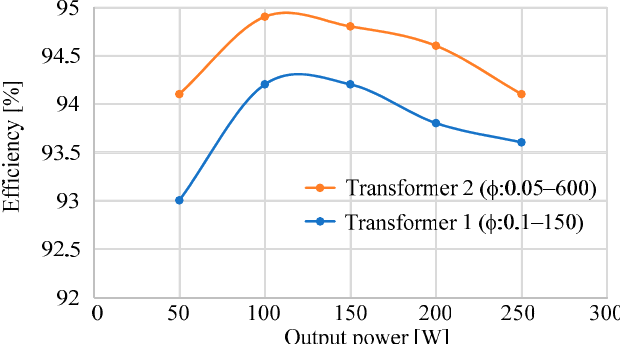
Figure 11. Comparison of conversion efficiency when number of strands is changed on wiring.